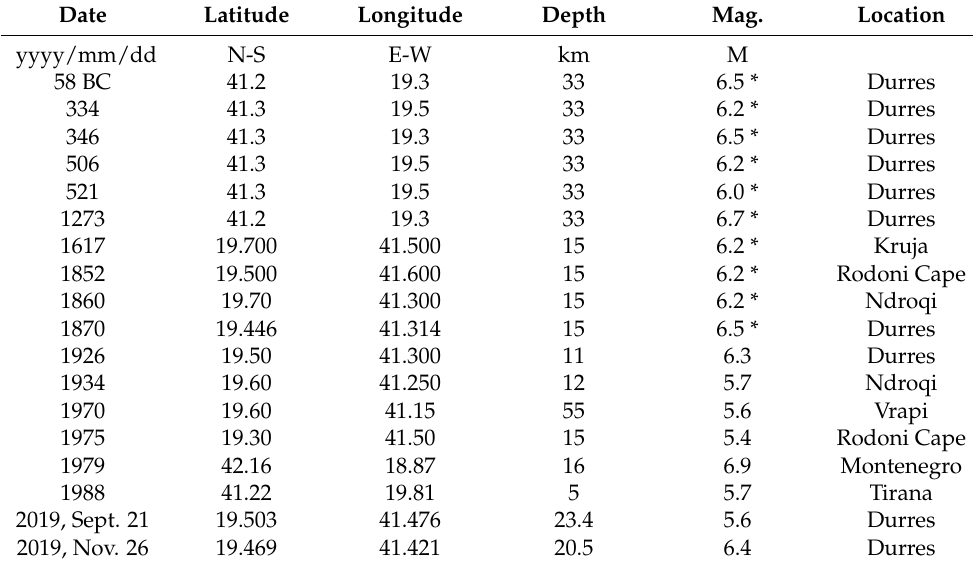
Table 1. Historical and instrumental era earthquakes (M > 6.0), 58BC-2019, in the Durres region (M implying moment magnitude and with * being the equivalent moment magnitude